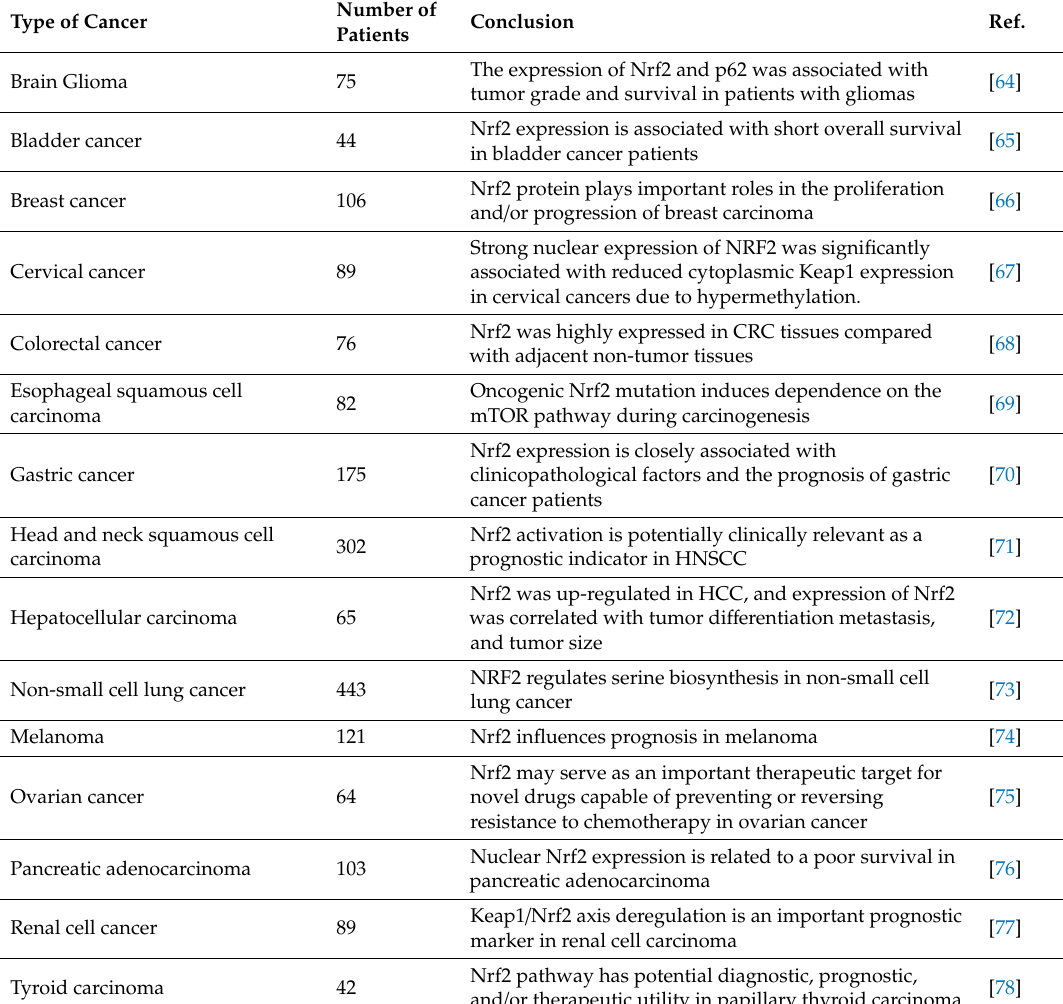
Table 1. The collection of clinical studies related to the role of Nrf2 in various cancer types. Type of